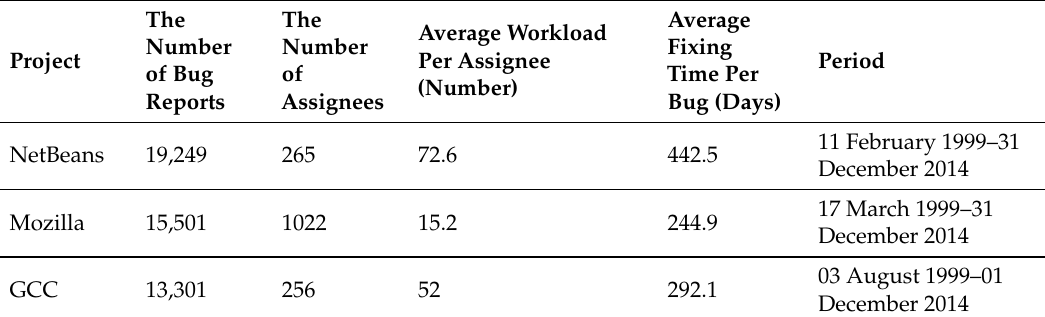
Table 2. Statistical results of average workload and fixing time in our